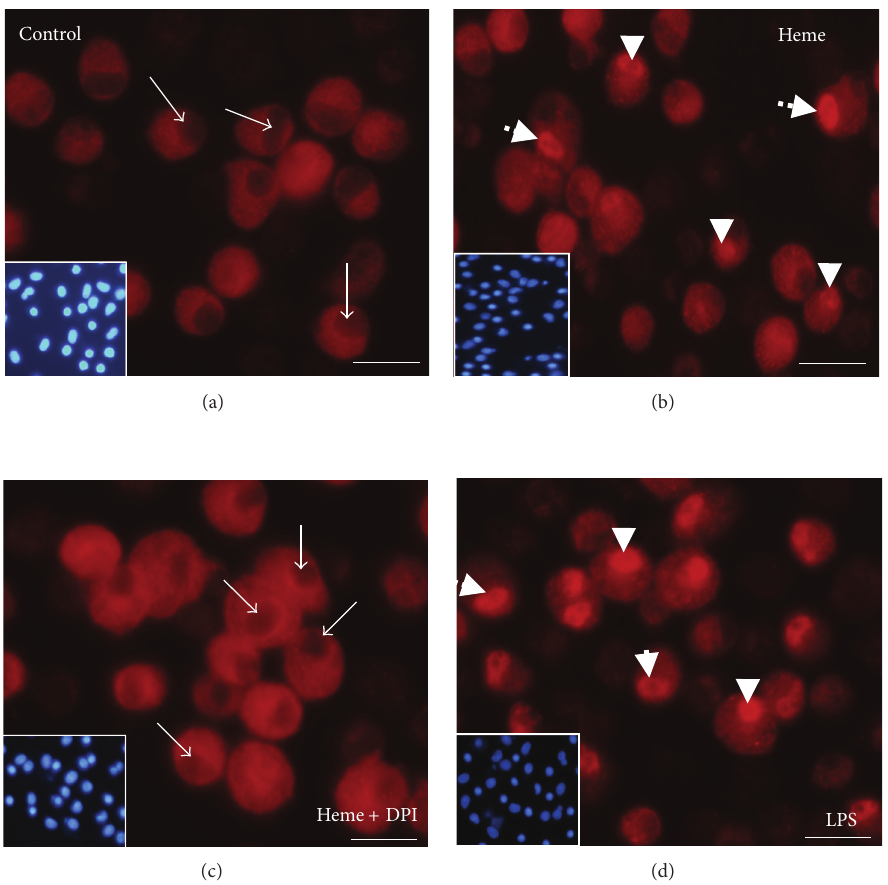
Figure 6: Heme induces NF- 𝜅 B nuclear translocation in AM. Rat AMs (1 × 10 6 /mL) were treated with heme (10 𝜇 M) for 1 hour. NF- 𝜅 B nuclear content was assessed through immunocytochemistry using a Cy3-conjugated anti-p65 subunit antibody. LPS (1 𝜇 g/mL) was used as positive control. The data shown are representative of three independent experiments. Arrows : nuclei without NF- 𝜅 B. Arrowheads : nuclei with NF- 𝜅 B.